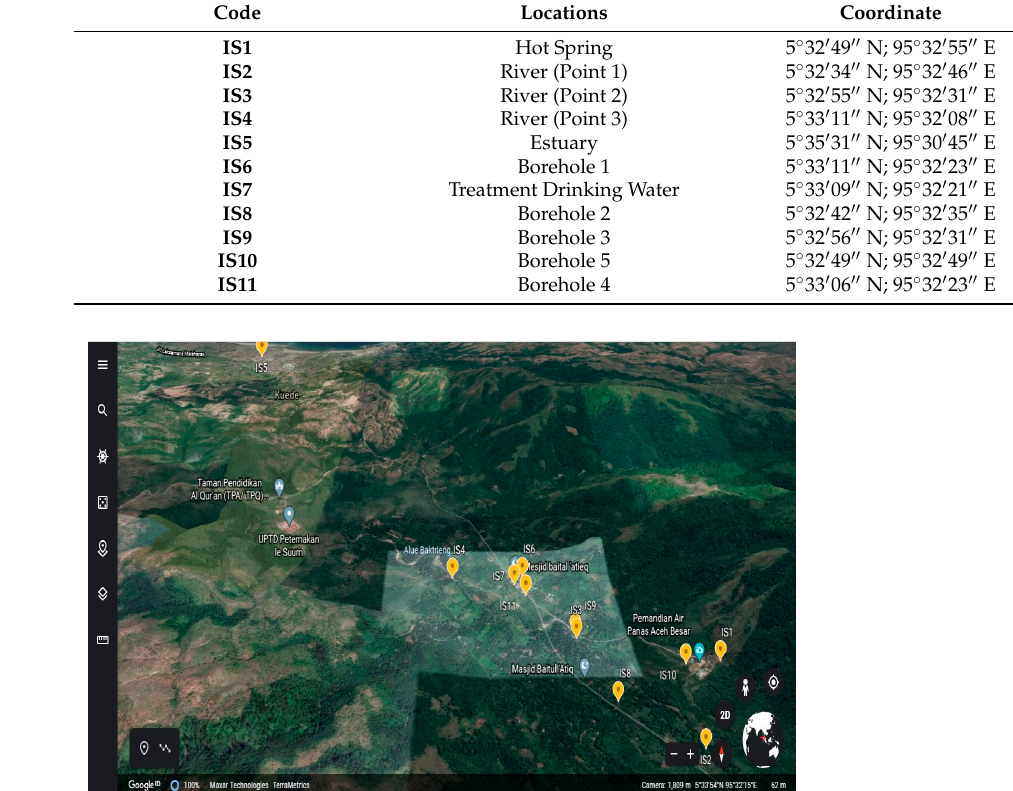
Table 1. Sampling point location for water and sediment samples in the Ie Seu’um area.